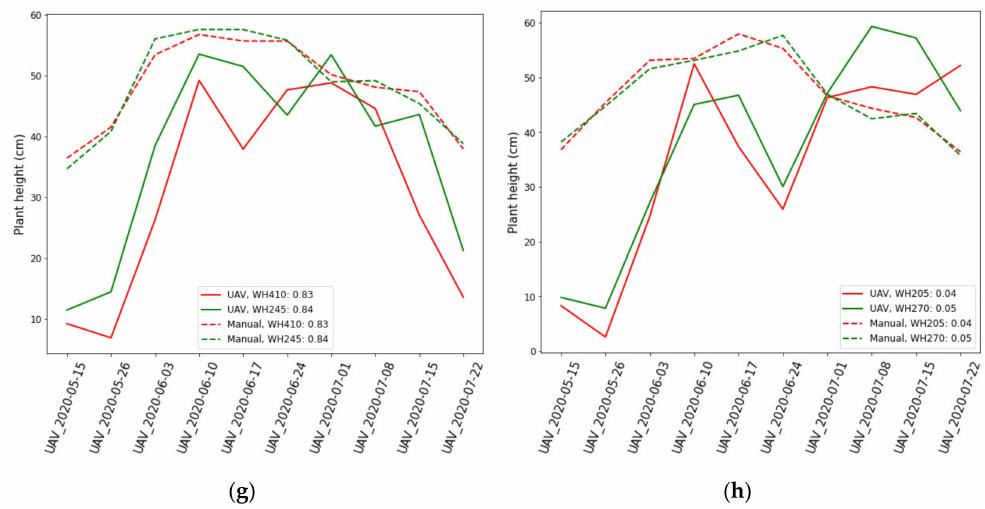
Figure 9. UAV-estimated individual plant growth and ground truth plant growth for two plants with a high correlation: ( a ) cabbage, ( c ) pumpkin, ( e ) barley, and ( g ) wheat. Additionally, for two plants with a low correlation: ( b ) cabbage, ( d ) pumpkin, ( f ) barley, and ( h )